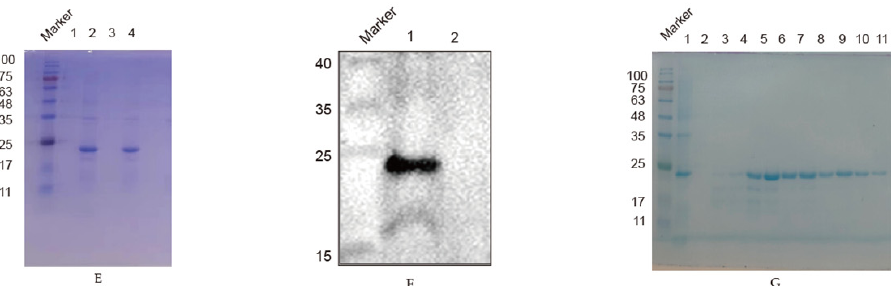
Figure 1. Selection and prokaryotic expression of NP truncated genes: ( A ) The structural characteristics of NP protein. Hydrophilicity, antigenicity and surface probability analysis of NP proteins were performed with the software Protean, in which the region marked in the red box was the selected fragment (71–243 AA); ( B ) Phylogenetic tree of the truncated NP protein. The homologies among the truncated NP (71–243 AA) and 44 strains of AIV were analyzed with BLASTP and software MEGA-X, and the results are shown in the phylogenetic tree. The truncated-sequence-derived strain in this study was marked in a red box; ( C ) NP PCR amplification. Lane 1 NP amplification; lane 2 negative; ( D ). Identification of recombinant plasmid pET-28a-NP by double enzyme digestion. Lane 1, pET-28a- NP; lane 2, pET-28a; ( E ) Protein expression identification. The recombinant NP protein was induced by IPTG and was analyzed on SDS-PAGE. Lane 1, pET-28a-NP not induced; lane 2, pET-28a-NP induced; lane 3, pET-28a-NP induced and supernatant after sonication; lane 4, pET-28a-NP induced and precipitated after sonication; ( F ) The recombinant protein reacted with positive serum. The fusion protein pET-28a-NP was incubated with chicken-positive serum. Lane 1 was for pET-28a-NP (24 KDa); lane 2 was for pET-28a vector control; ( G ) Purification of recombinant protein. Lane 1, effluent after column hanging; lanes 2–11, effluent after elution with different imidazole concentrations. Imidazole concentrations of 20, 30, 50, 80, 120, 150, 150, 250, 250 and 500 mM.